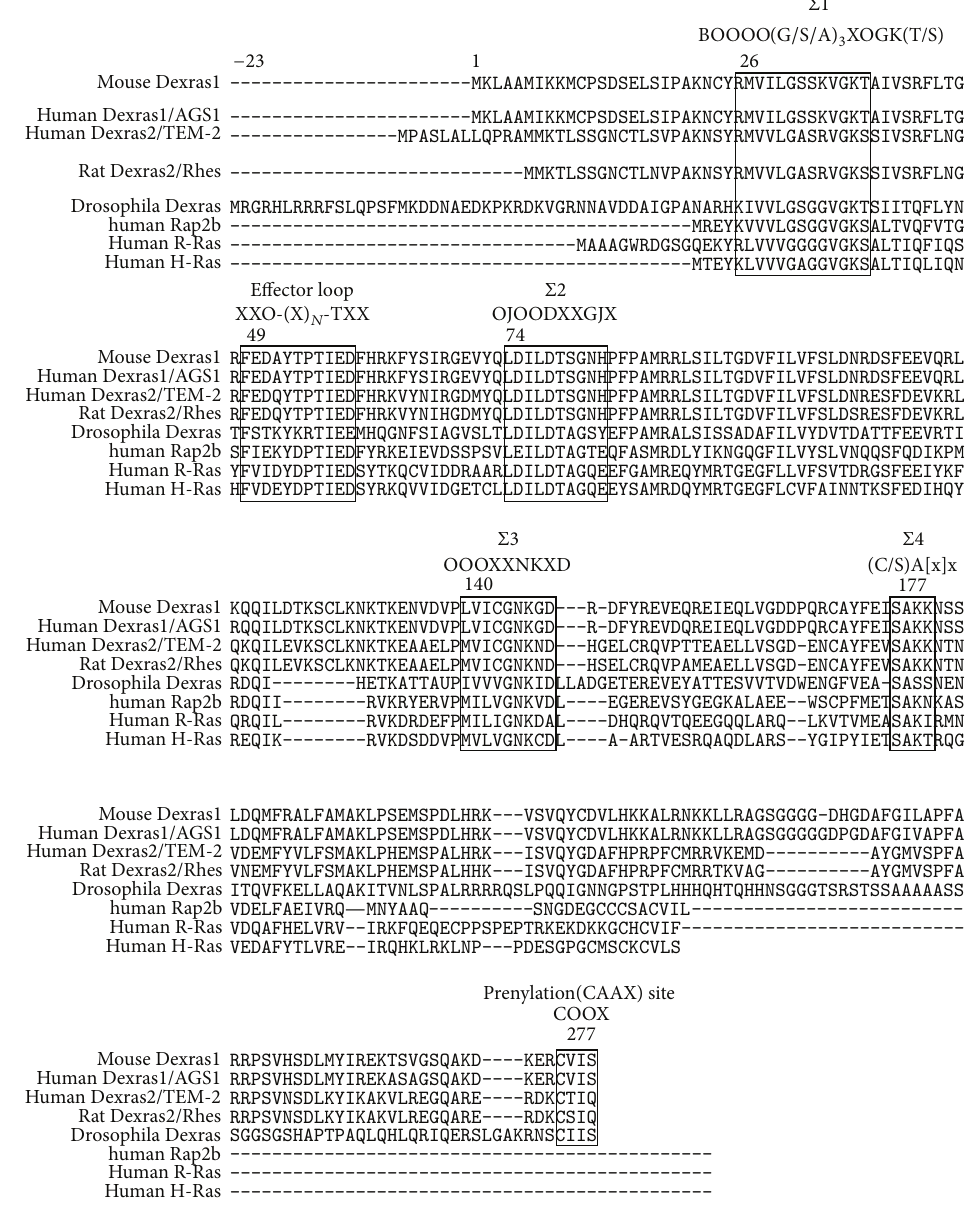
Figure 4: Alignment of Dexras1 with related hormone-responsive basic GTP-binding proteins (Dexras2, Drosophila Dexras) and repre- sentative Ras family members. Reference: Graham et al.